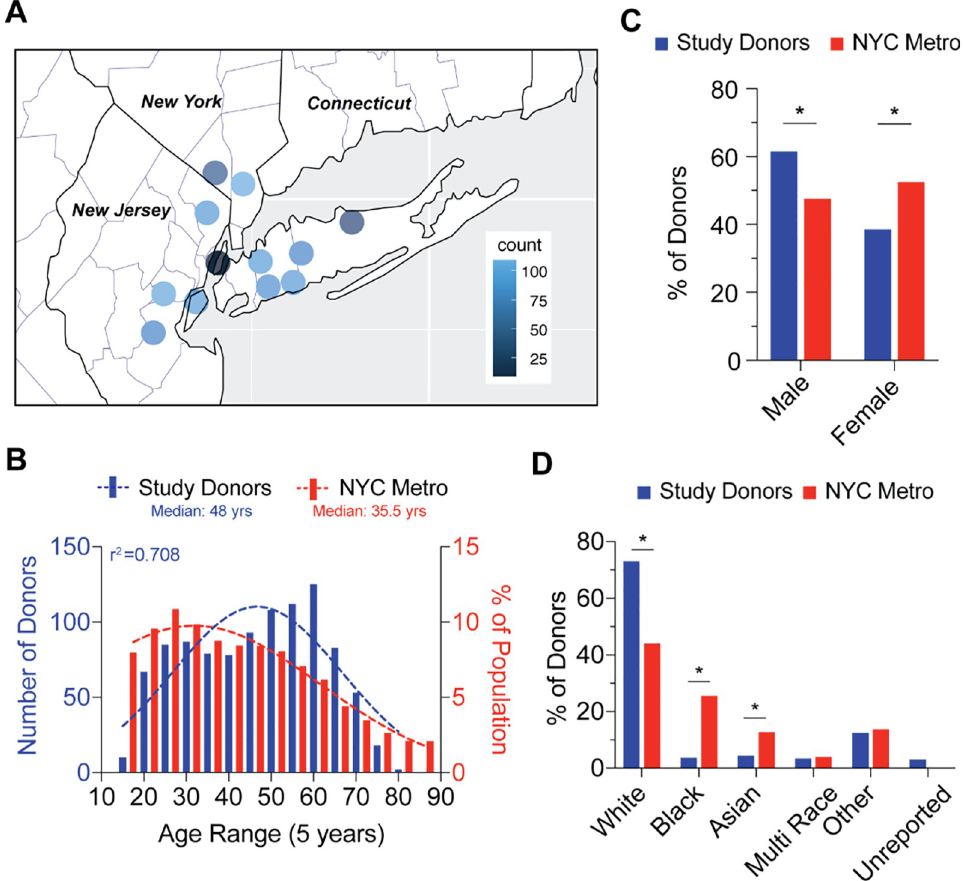
Fig 1. Blood donor demographics of NYC metro area. A; Choropleth of donation site locations used for collection of blood donor samples. Heatmap (gradient bar, top) corresponds to frequency of donors collected at each site. B; Distribution of NYC Metro area donor age (red bars) compared to NYC demographics (blue bars). Dotted lines represent best fit to a Gaussian distribution and r2 value represents calculated goodness of fit to distribution plot. C; Gender frequency of NYC Metro area donors (red bars) compared to NYC demographics (blue bars). Chi-square test for goodness of fit to observed (donors) versus expected (NYC demographics) results; � p < 0.01. D; Ethnicity frequency of NYC Metro area donors (red bars) compared to NYC demographics (blue bars). Chi-square test for goodness of fit to observed (donors) versus expected (NYC demographics) results; � p < 0.01.